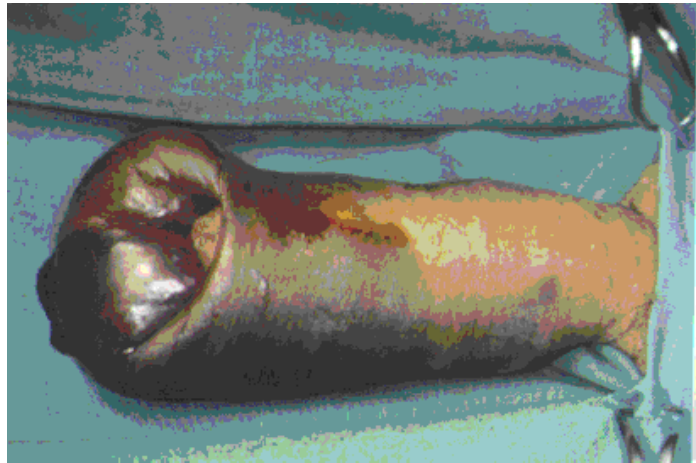
FIGURE 2. Penile swelling and hematoma are evident even if the extent of the lesion in corpora cavernosa is not always comparable to physical